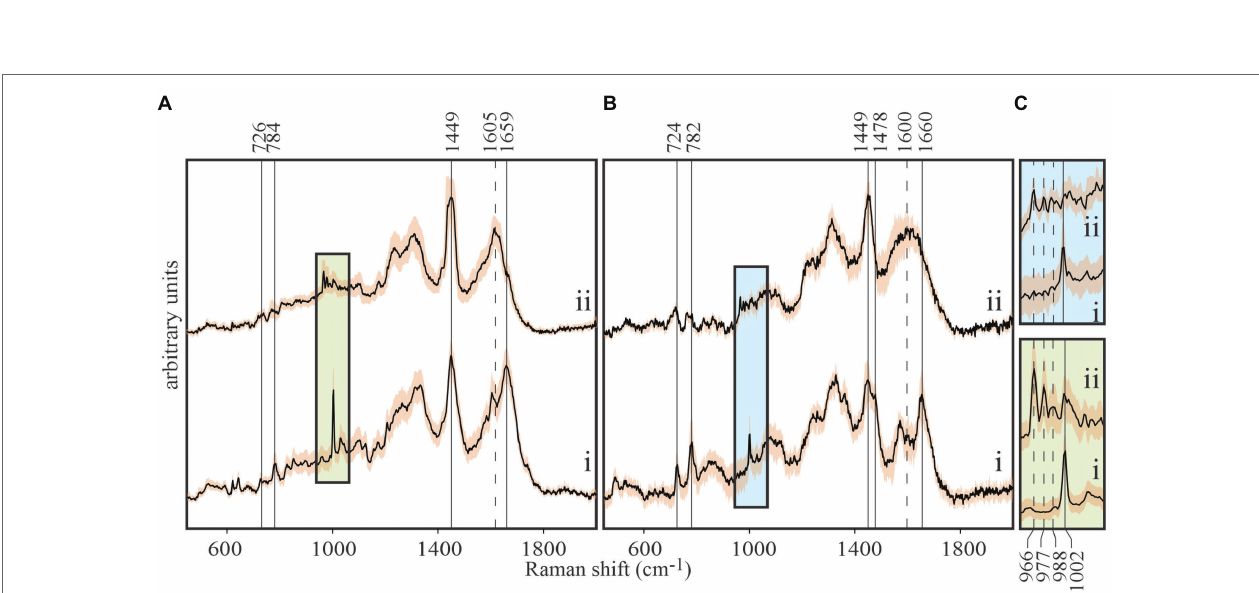
FIGURE 3 | Tracing carbon flow from 13 C-labeled Emiliania huxleyi to EhV-163 viruses by stable isotope probing (SIP) and Raman microspectroscopy. (A) Stacked spectra of E. huxleyi grown in unlabeled media (i), and grown in media with 13 C-bicarbonate (20 mM) as the sole inorganic carbon source (ii). (B) Stacked spectra of purified EhV-163 virions obtained from unlabeled (i) and 13 C-labeled (ii) E. huxleyi hosts. Solid vertical lines show the Raman peaks that undergo significant reds shift due to 13 C enrichment. (C) Magnified spectral region containing Phe’s ring breathing mode peaks for the host (lower panel) and EhV-163 virions (upper panel). Emission peaks from the four observed isotopologues are specified by vertical lines. Shading over spectra represents ±1 SD about the mean observed at every wavenumber for spectra from 20 cells or 20 viral